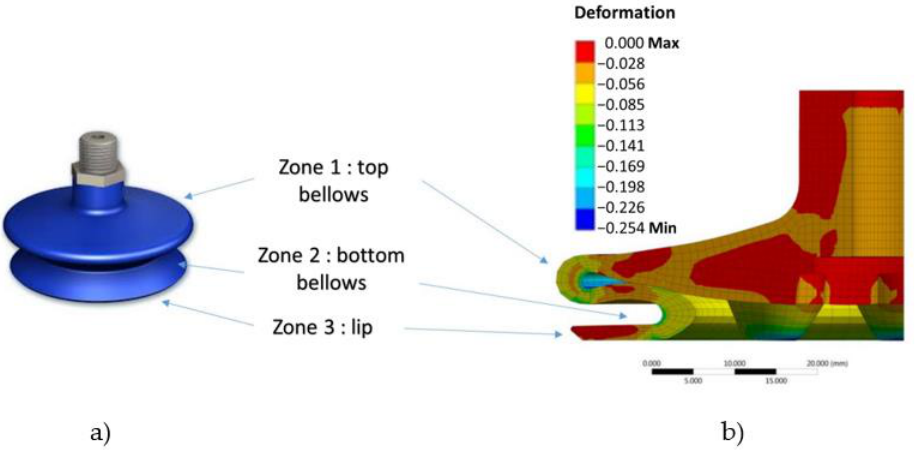
Figure 1. Decomposition of three zones that need to be monitored: ( a ) An SC provided by the in- dustrial partner; and ( b ) mechanical deformation of SC based on FEM.